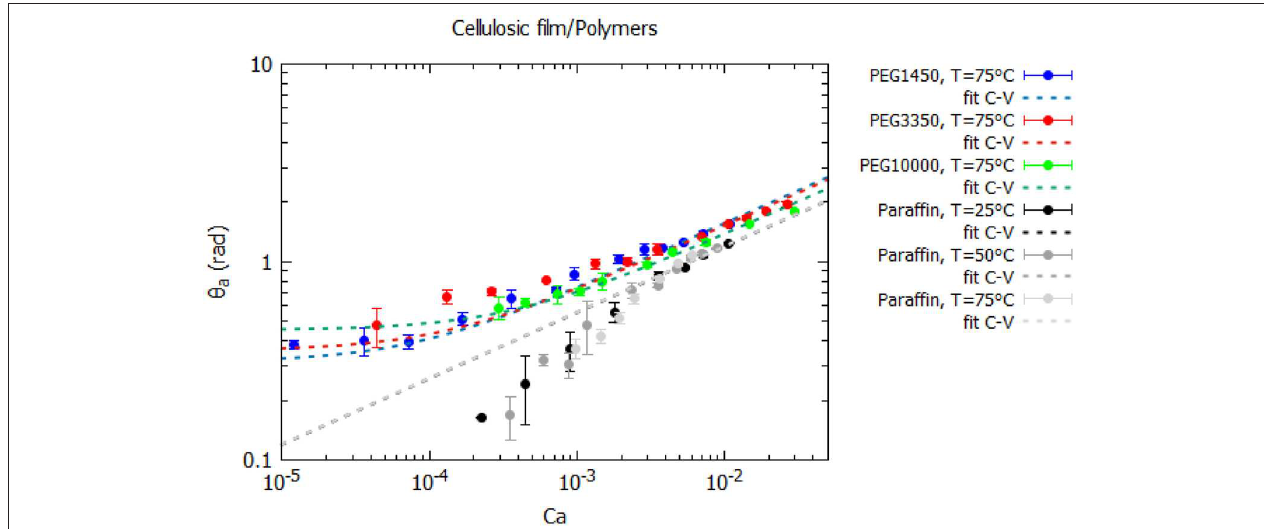
FIGURE 8 | θ a as a function of Ca for polymers at different temperatures on cellulosic films and prediction of Cox-Voinov law.